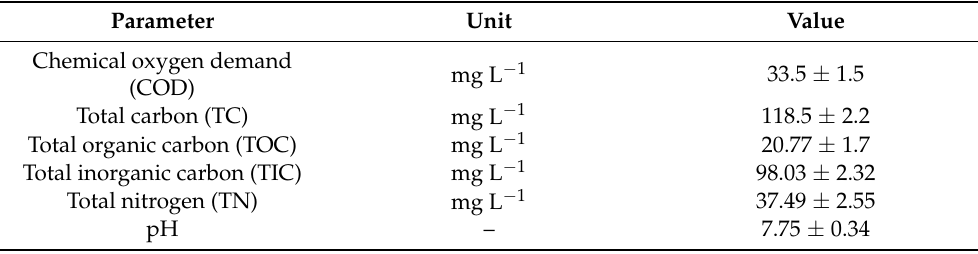
Table 4. Characteristics of the used wastewater (No. of samples = 3).